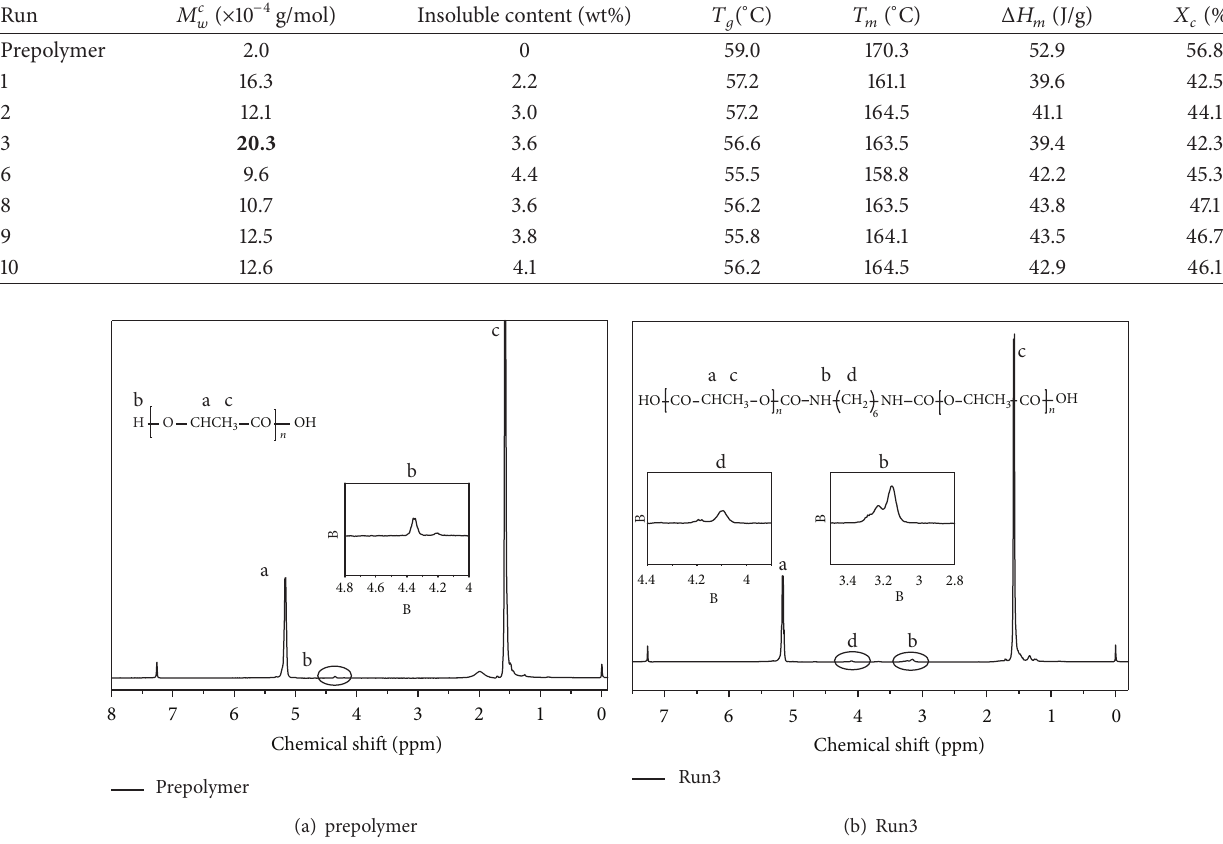
Figure 3: 1 H-NMR spectrum of PLA prepolymer (a) and the PLA chain extended with HDI (Run3) (b).